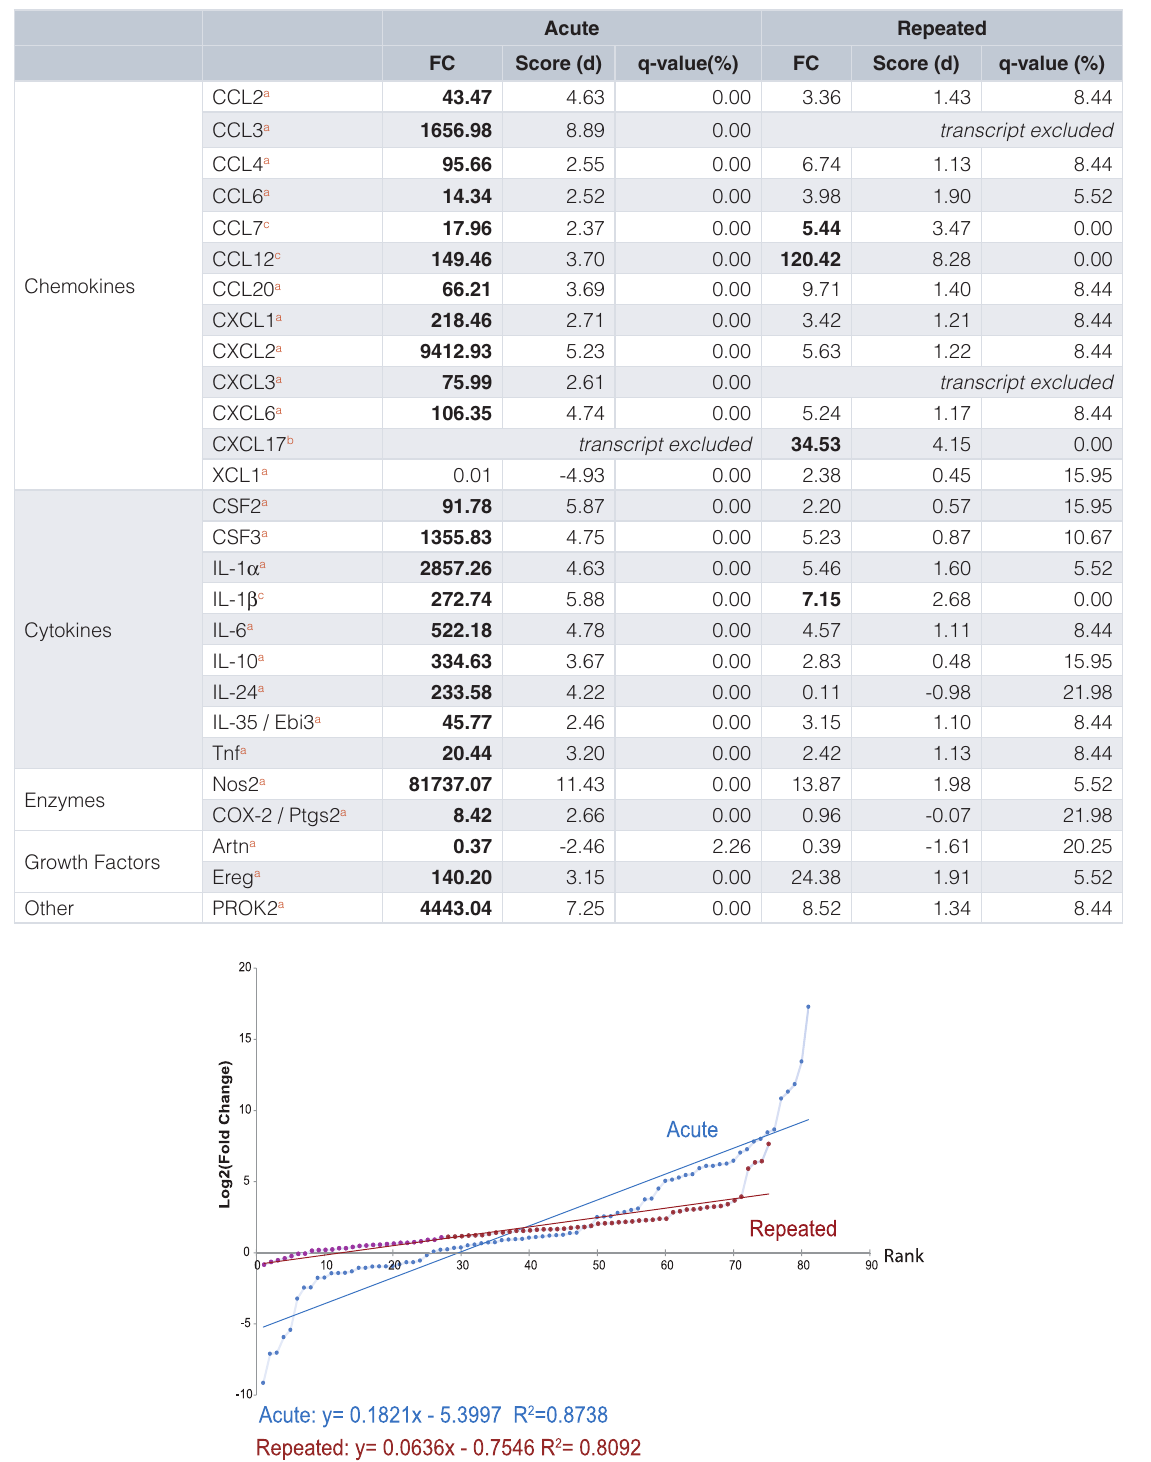
Table 4. Significance analysis of qRT-PCR array (SAM) results for acute and repeated bladder inflammation. Significant fold difference in acute model a , repeated model b , or both c ; Significance level, FDR q=0% denoted by bold text.